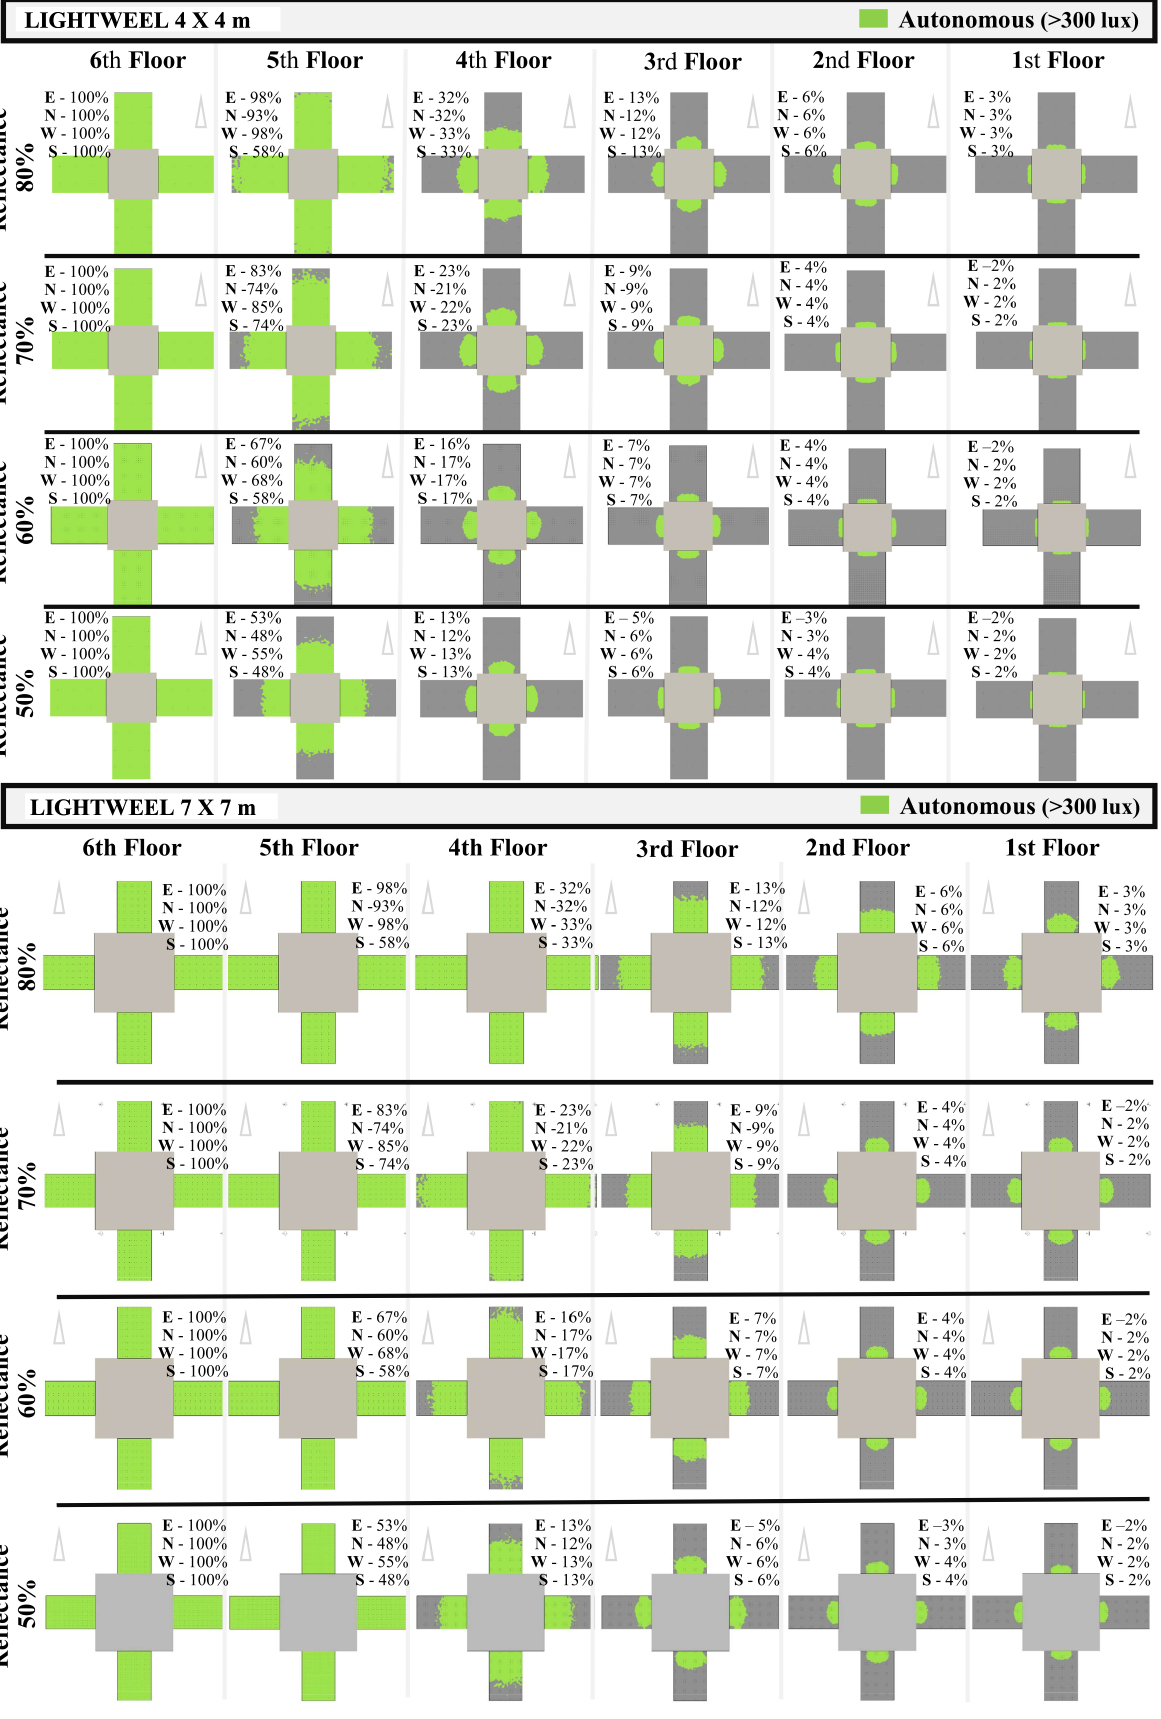
Figure 5. sDA values in the model at Macapá